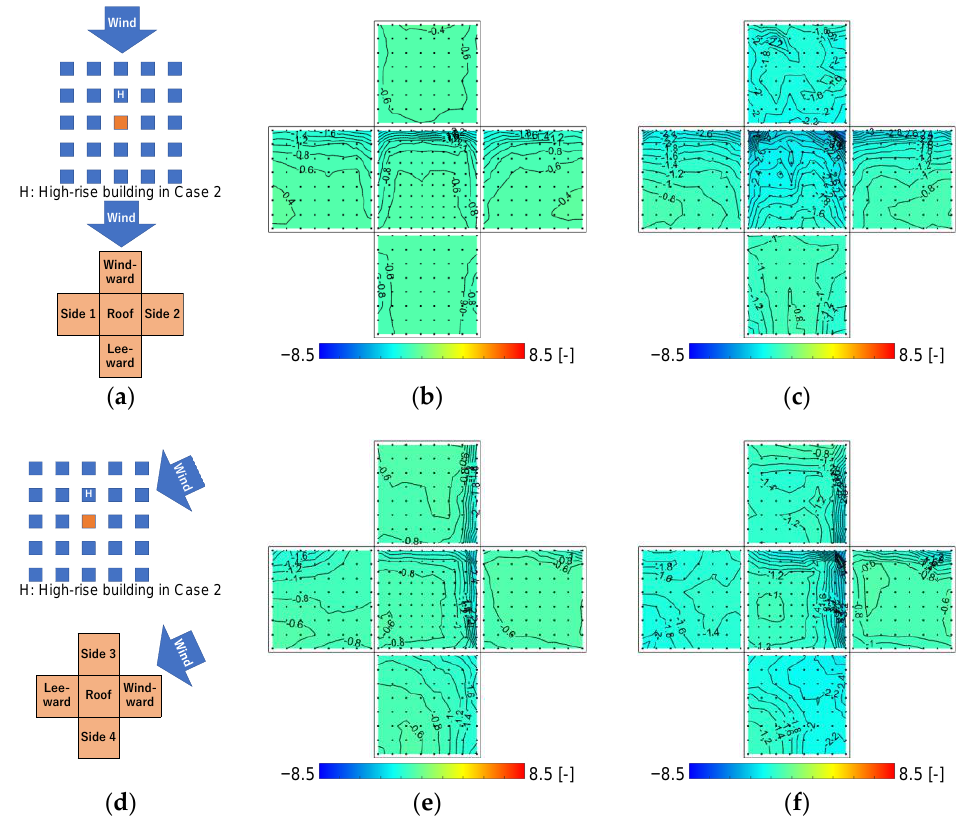
Figure 14. Negative 𝑝𝑒𝑎𝑘𝐶 𝑝 ; ( a ) building model arrangement and prevailing wind direction for ( b , c ); ( b ) wind direction of 0° in Case 0 with no high-rise building; ( c ) wind direction of 0° in Case 2 with a high-rise building next to the pressure measurement model; ( d ) building model arrangement and prevailing wind direction for ( e , f ); ( e ) wind direction of 65° in Case 0; ( f ) wind direction of 65° in Case 2.